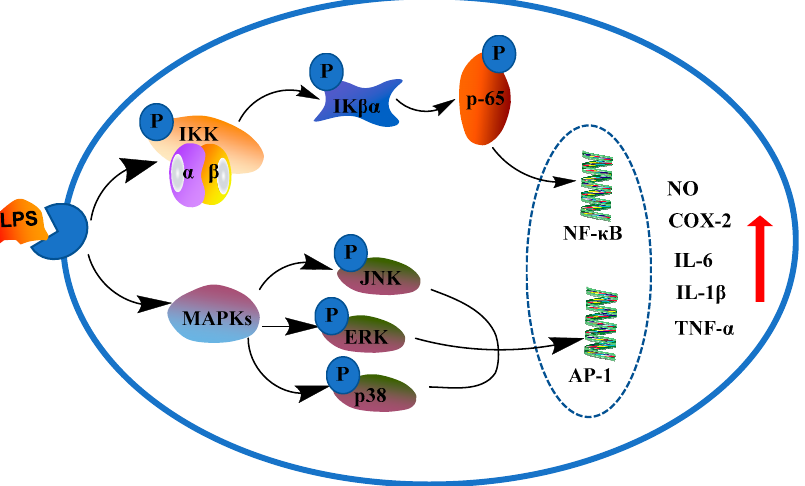
Figure 1. NF- κ B and MAPK inflammatory pathways.